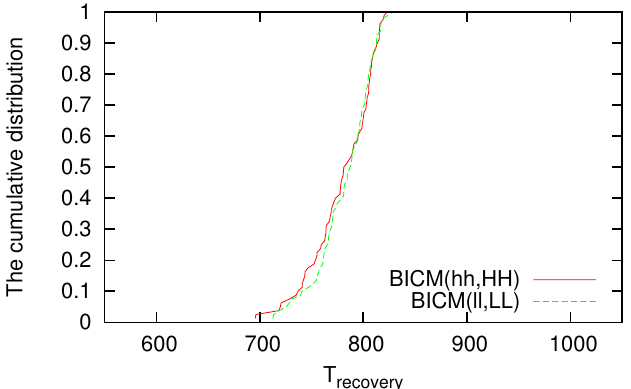
Figure 6. Cumulative distribution of the time needed for the data delivery ratio to recover to over 99.9% ( T recovery ) when nodes are removed by random